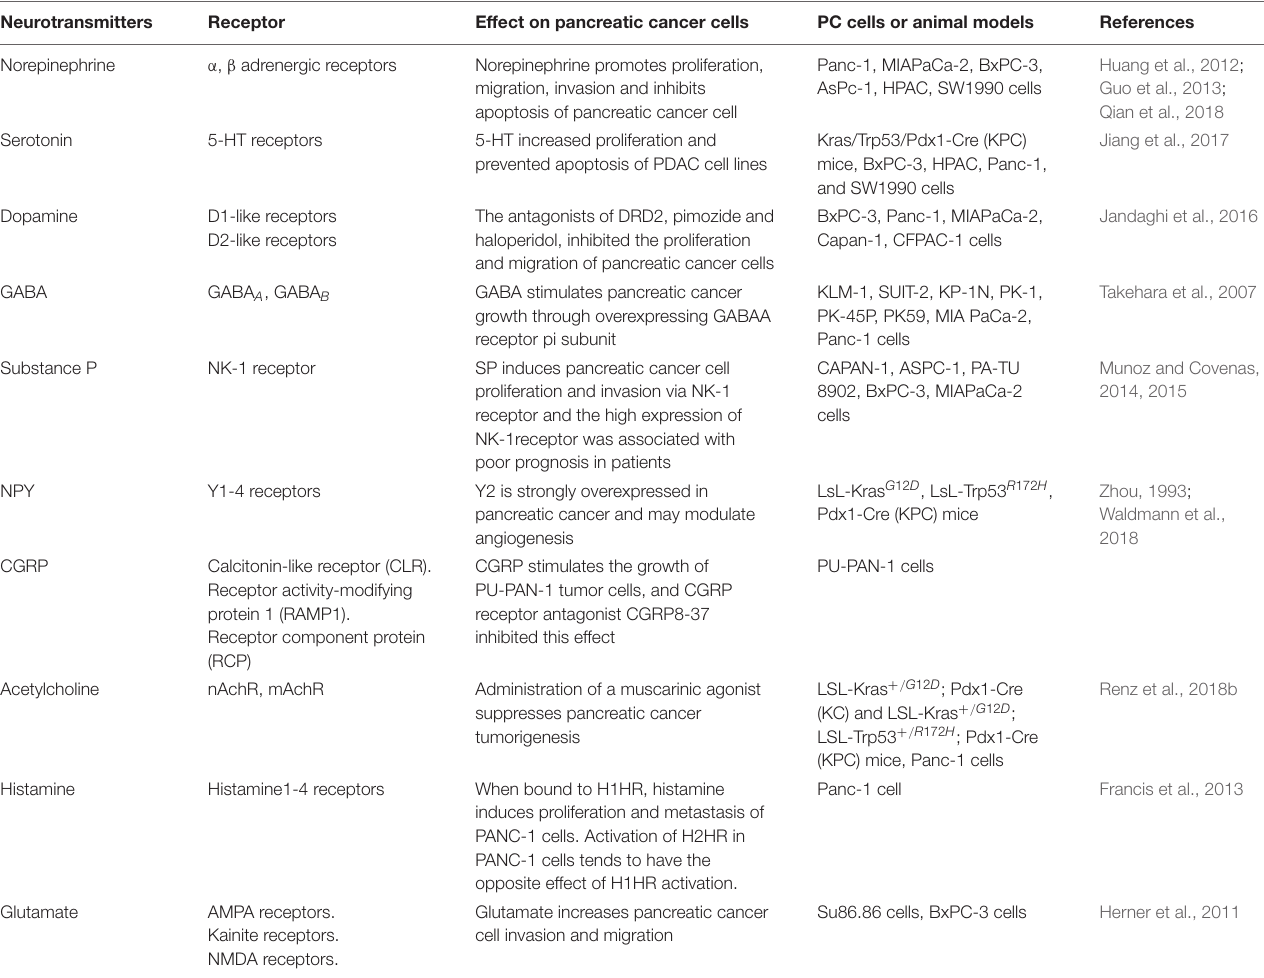
TABLE 2 | Summary of the studies on the role of neurotransmitters in pancreatic